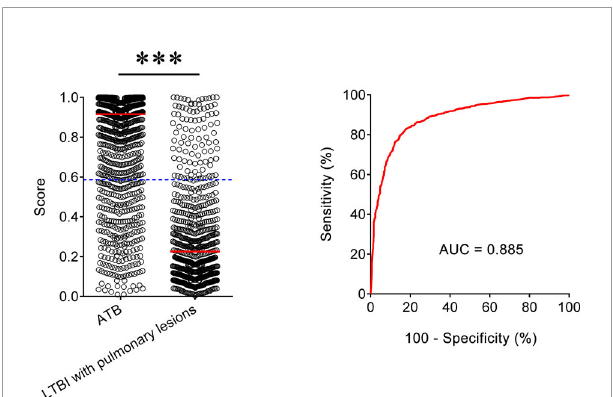
FIGURE 3 | The performance of established model for discriminating ATB from LTBI with pulmonary lesions. Scatter plots showing the score of the diagnostic model in ATB patients (n = 1,097) and LTBI individuals with pulmonary lesions (n = 671). Horizontal lines indicate the median. *** P < 0.001 (Mann-Whitney U test). Blue dotted lines indicate the cutoff value in distinguishing these two groups. ROC analysis showing the performance of the diagnostic model in distinguishing ATB from LTBI with pulmonary lesions. ATB, active tuberculosis; LTBI, latent tuberculosis infection; AUC, area under the